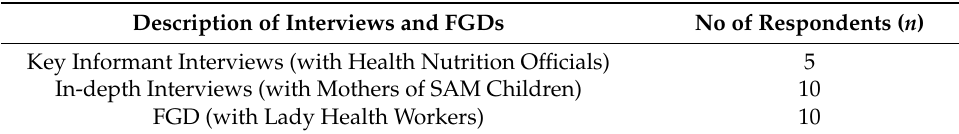
Table 1. Details of Interviews and FGDs with Study Respondents ( n =